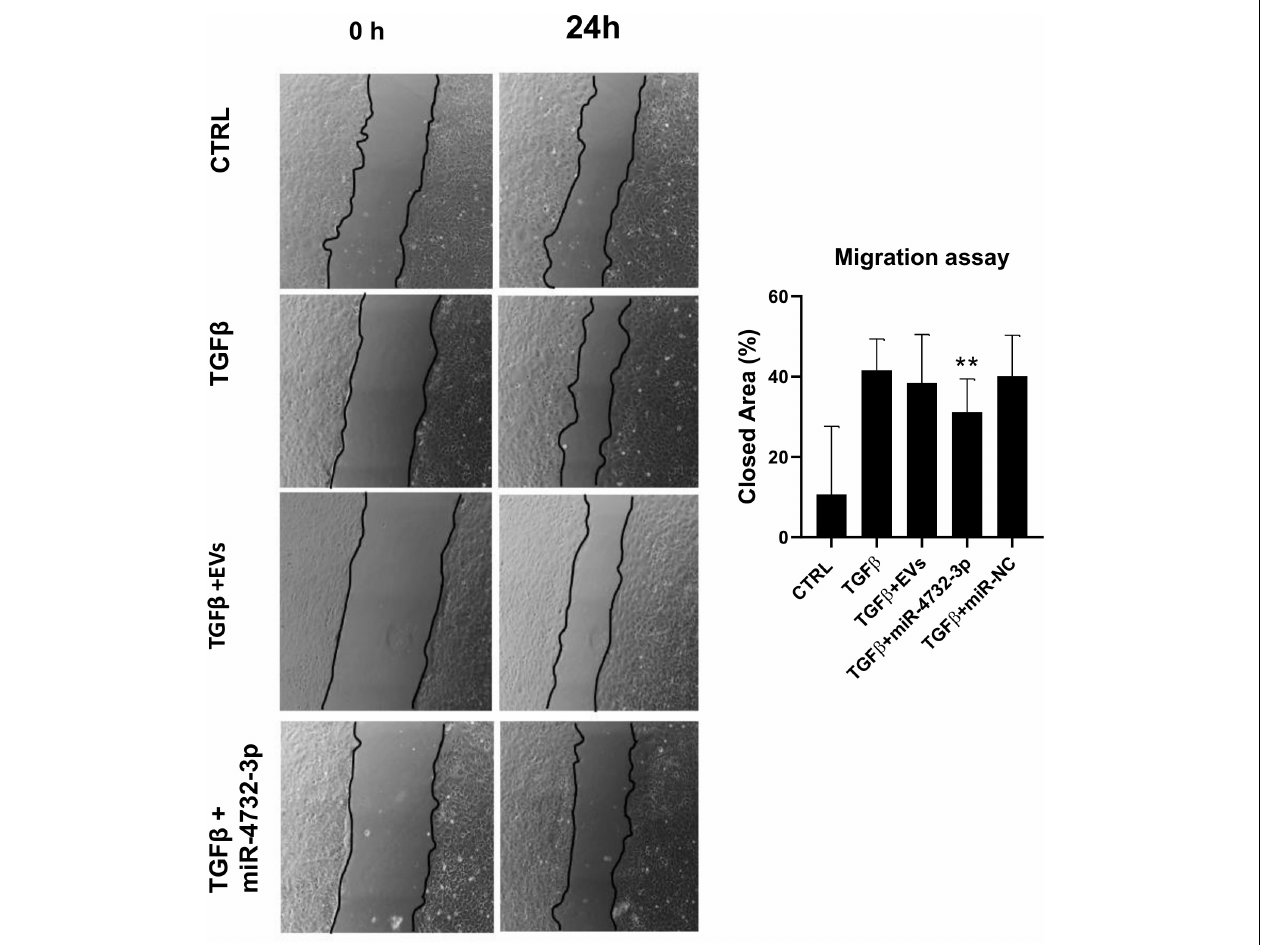
FIGURE 3 | Effect of EVs and miRNA 4732-3p on fibroblast migration. The percentage of closed area was calculated from the difference between the area at baseline and after 24 h. Fibroblasts were cultured in standard culture condition (CTRL) or treated with 10 ng/mL of TGF β alone or with 30 µ g/mL of EVs (TGF β + EVs) transfected with 20 nM of lipofectamine-miRNA 4732-3p complexes or 20 nM of miR-Negative Control. Images were captured on an inverted microscope at 4 × magnification. The area of the scratch was measured using ImageJ ( n = 6, ** p < 0.01).